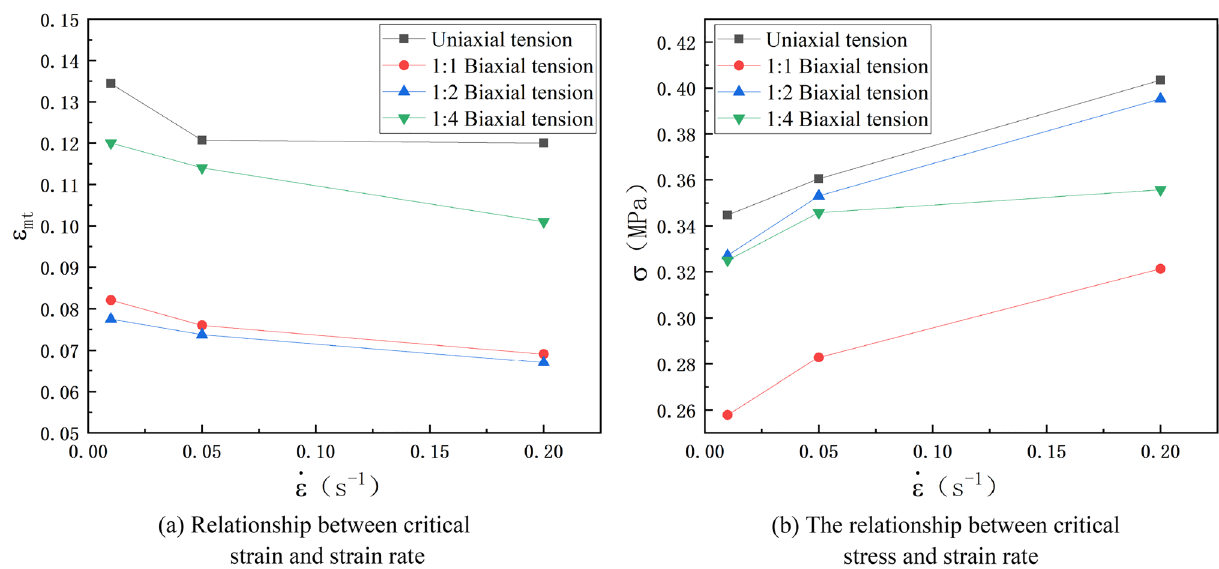
Figure 12. Variation curves of critical stress and strain of HTPB propellant at dewetting point under different loading conditions at room